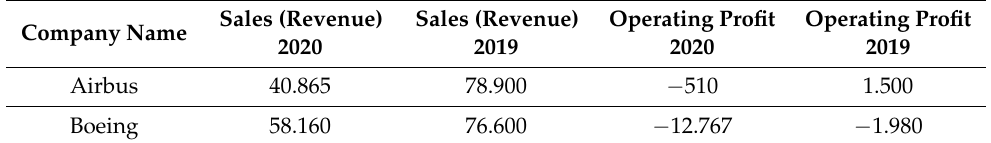
Table 1. Top 2 aerospace companies by revenue 2020 (million USD)